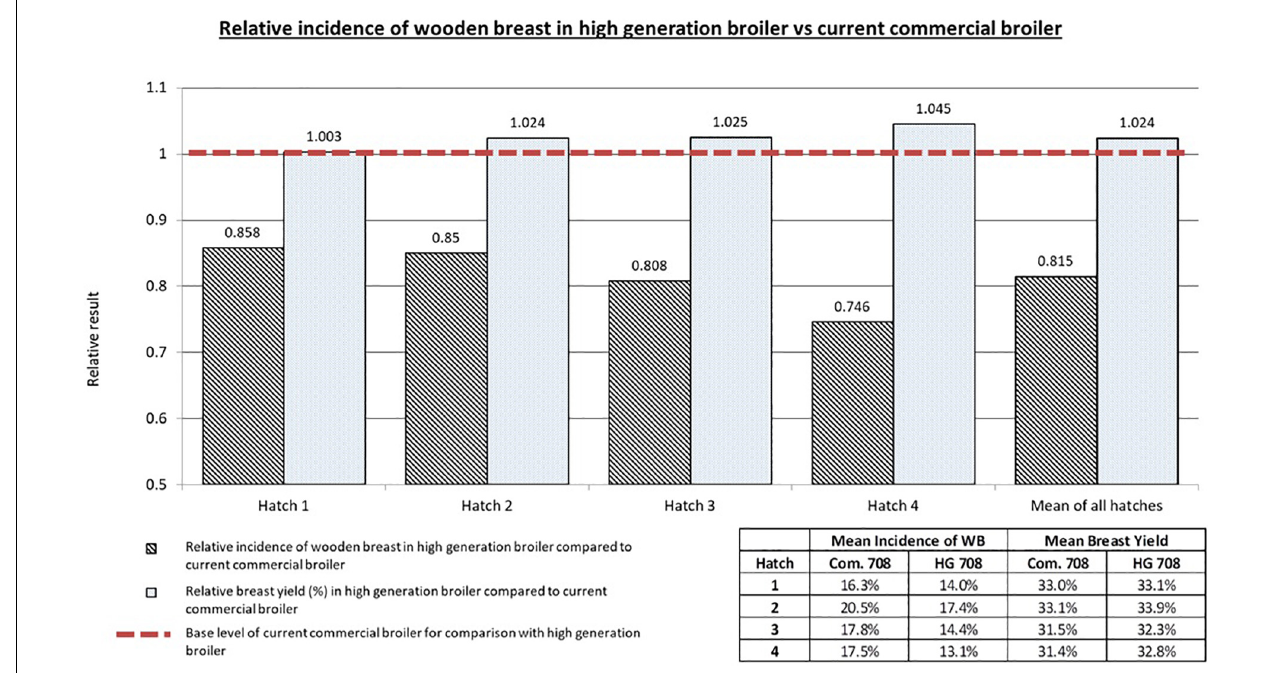
FIGURE 5 | Relative results for wooden breast incidence (scores 1, 2 and 3) and breast yield of the high generation broiler compared to the current commercial broiler in study 2. Mean WB incidence and BY values are also given for all groups. An overall decrease in total wooden breast incidence can be seen as a result of genetic selection whilst simultaneously improvements in breast yield can be achieved.